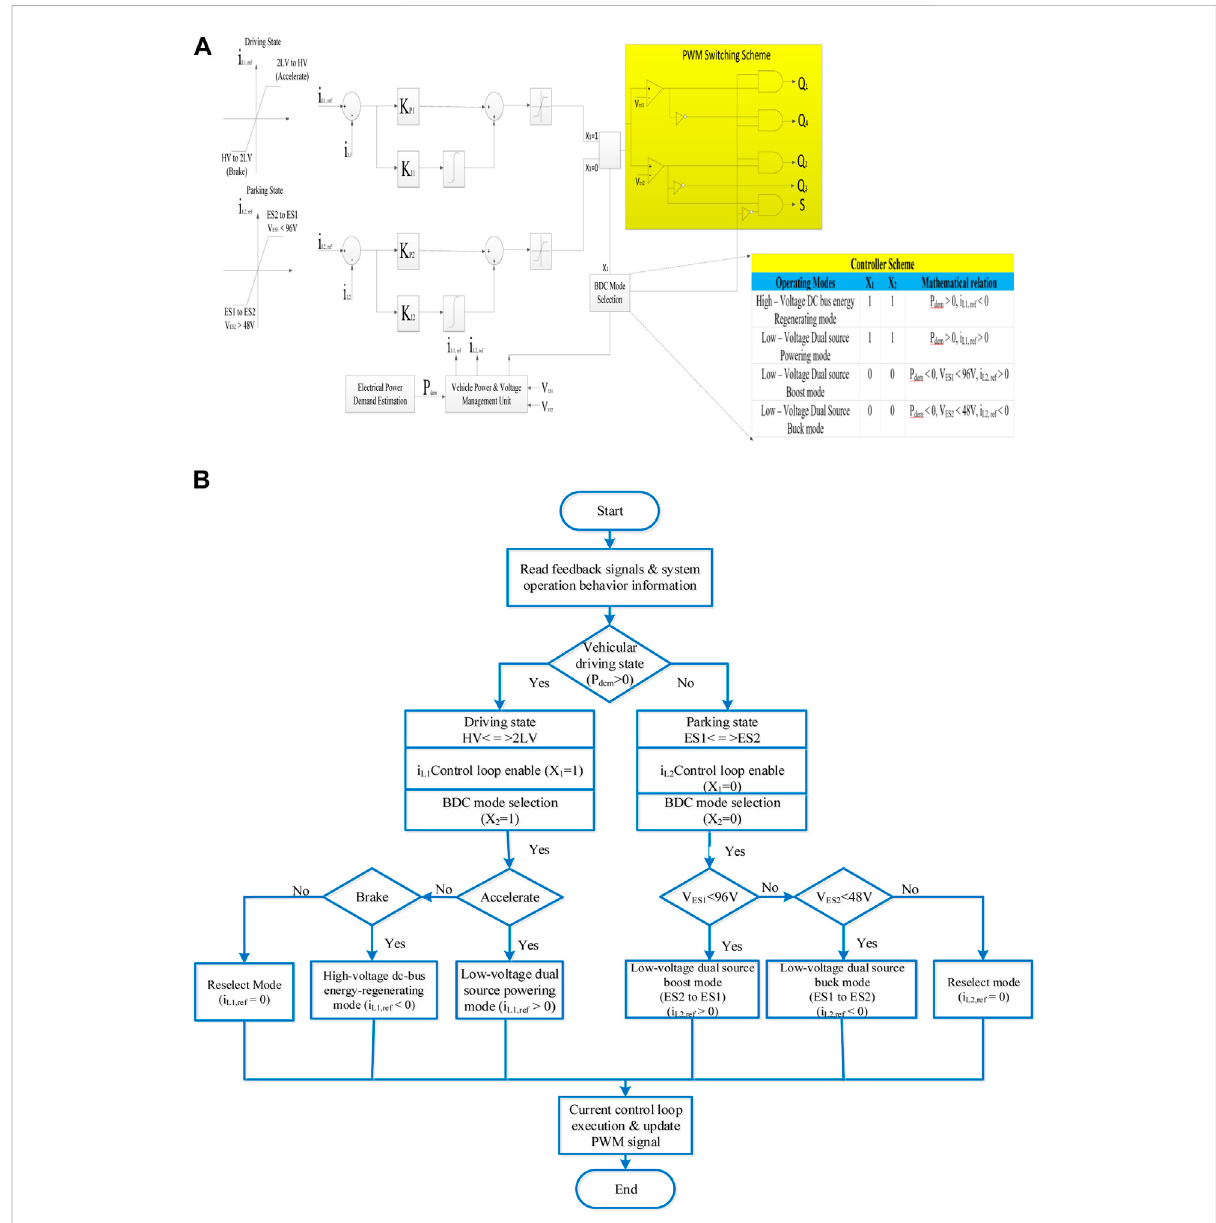
FIGURE 10 (A) Blockdiagram oftheclosed-loop controlmethod; (B) designedDSP fl owchart oftheproposed BDCC ’ smultipleoperatingmodes (Laietal.,